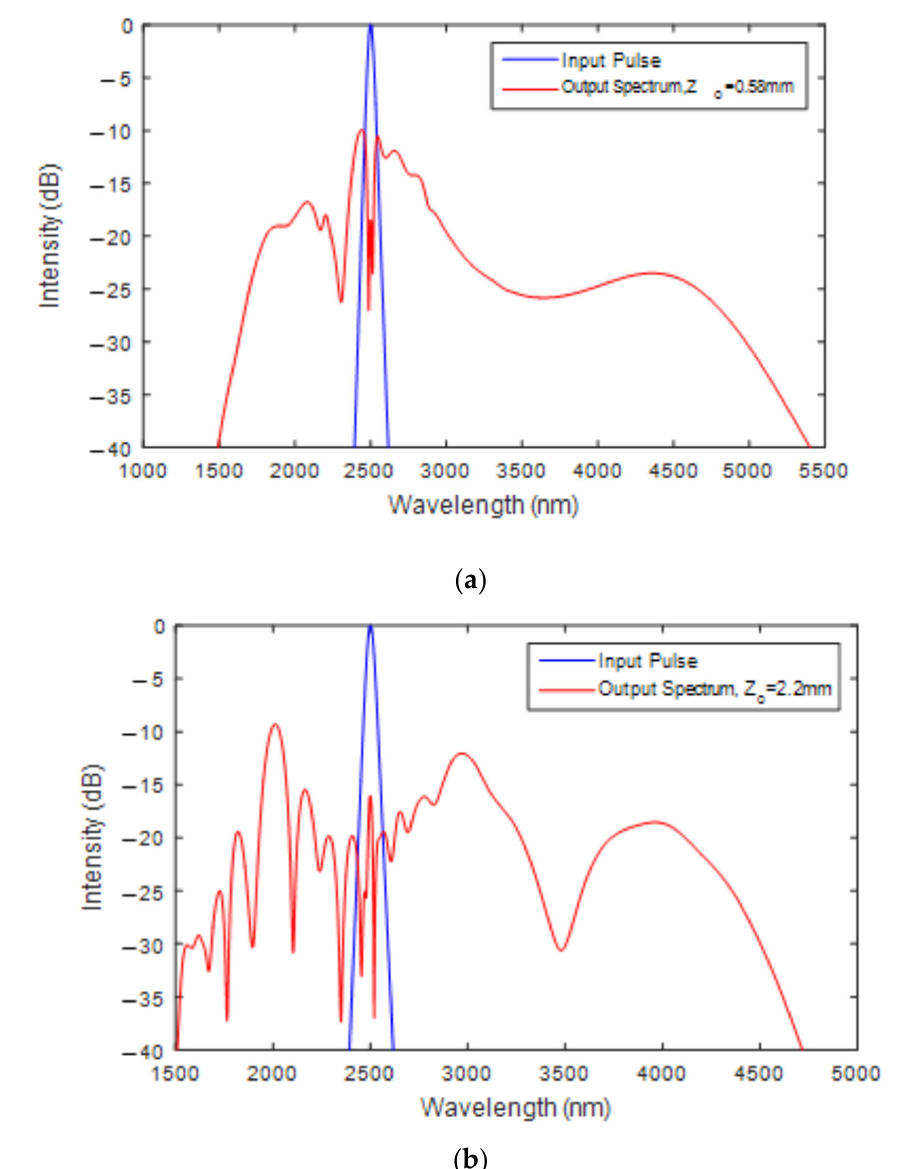
Figure 5. Spectral evolution of broadening in ( a ) S ‐ PCF and ( b ) C ‐ PCF.